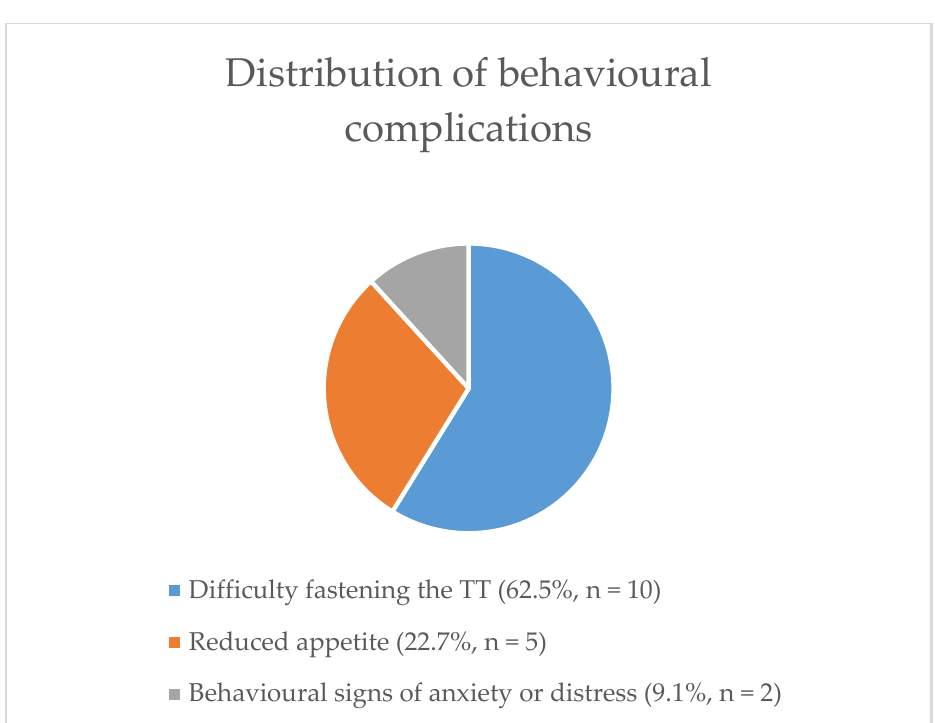
Figure 2. The distribution of behavioural complications reported by respondents ( n = 16).